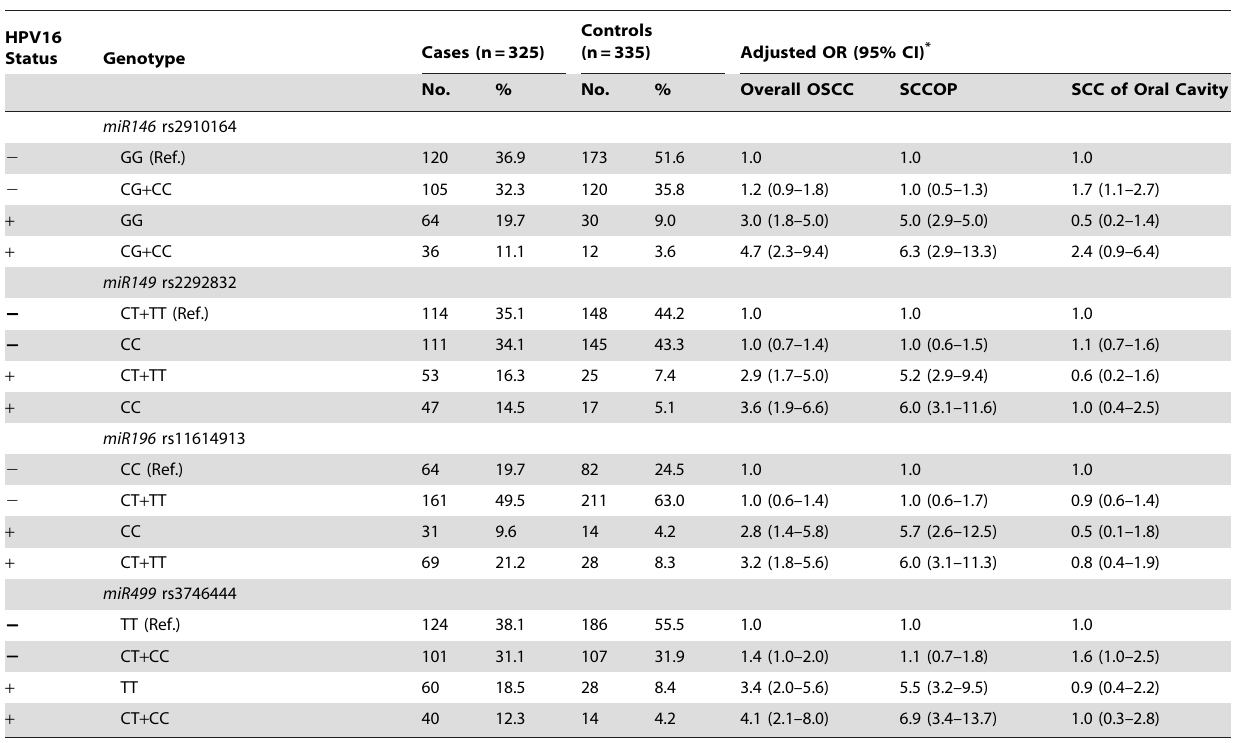
Table 4. Joint Effect of HPV16 Seropositivity and MicroRNA Genotypes on OSCC Risk.